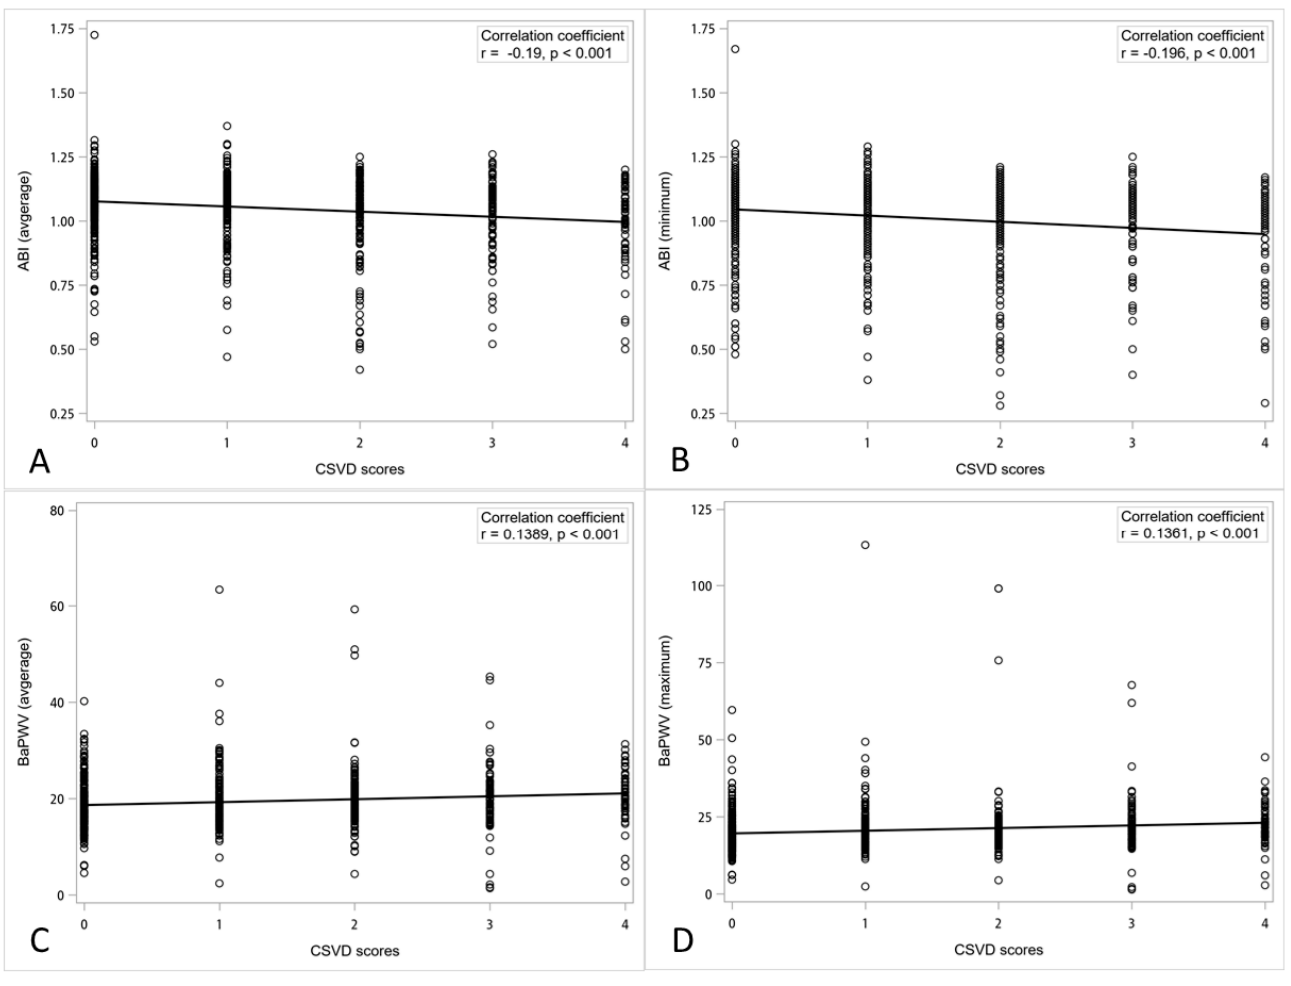
Figure 3. Relationship between the ABI/baPWV and CSVD scores. ( A , B ) The correlation between the average and minimum ABI and total CSVD scores. ( C , D ) The correlation between the average and maximum baPWV and total CSVD scores.